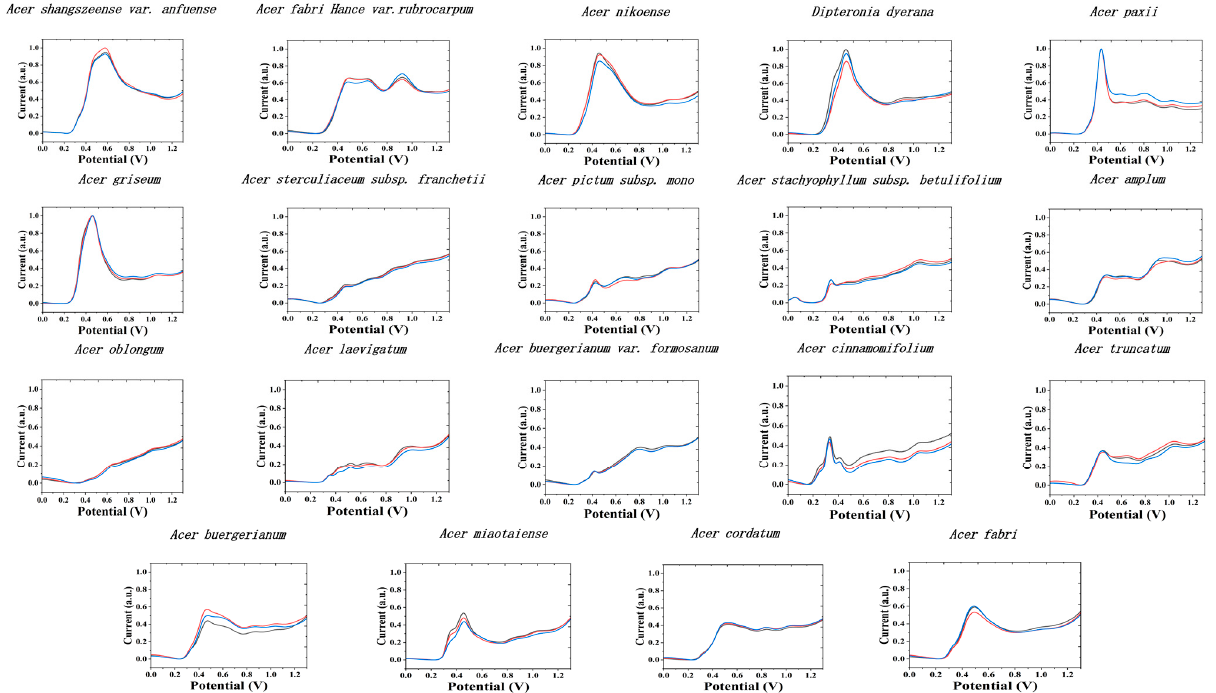
Figure 2. Electrochemical fingerprint of A. shangszeense var. anfuense , A. pictum subsp. mono , A. amplum , A. truncatum , A. miaotaiense , A. nikoense , A. griseum , A. fabri Hance var. rubrocarpum , A. paxii , A. oblongum , A. laevigatum , A. buergerianum var. formosanum , A. cinnamomifolium , A. buergerianum , A. cordatum , A. fabri , A. sterculiaceum subsp. Franchetii , A. stachyophyllum subsp. betulifolium , and Dipteronia dyerana after ethanol extraction and recording in ABS (0.1 M, pH 7) condition.